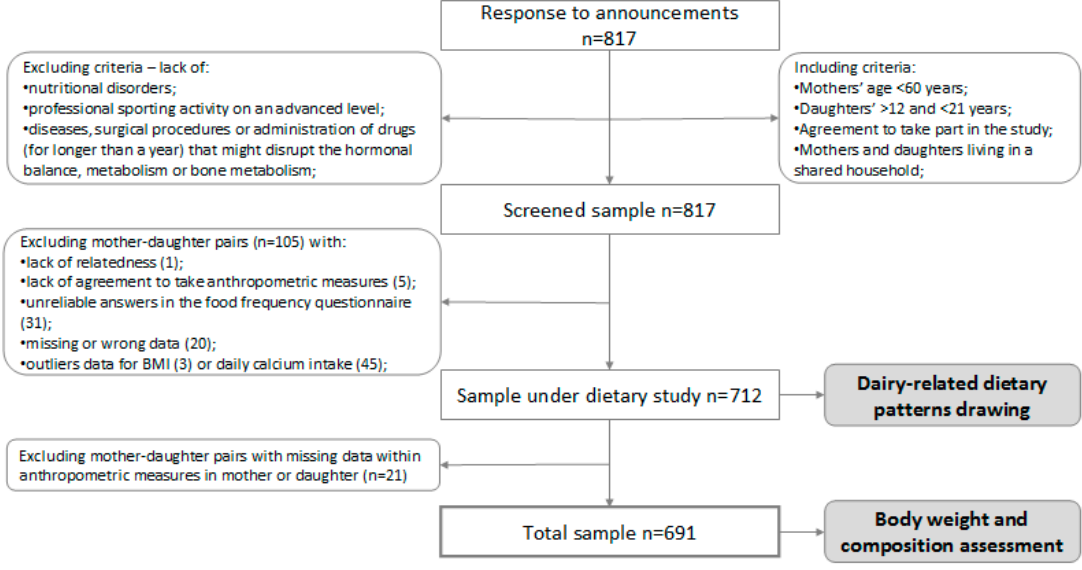
Figure 1. Flowchart: Study design and data collection.